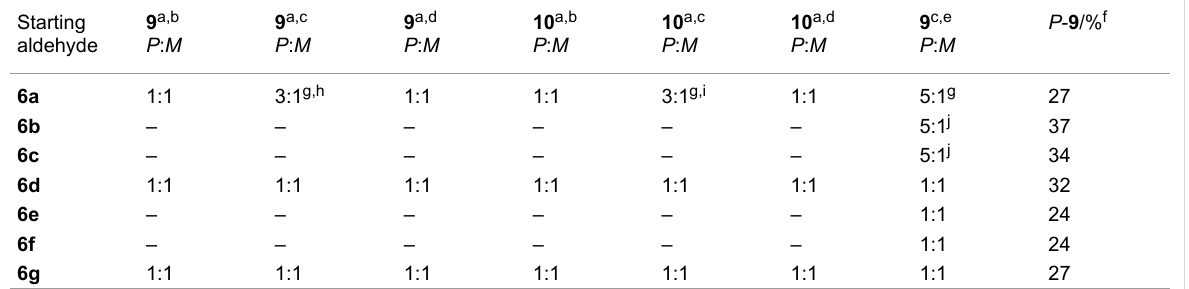
Table 3: Preparative scale synthesis of imidazolidines 9 and oxazolidines 10 using (a) a Dean-Stark trap (DS) and (b) a sealed tube. Starting aldehyde